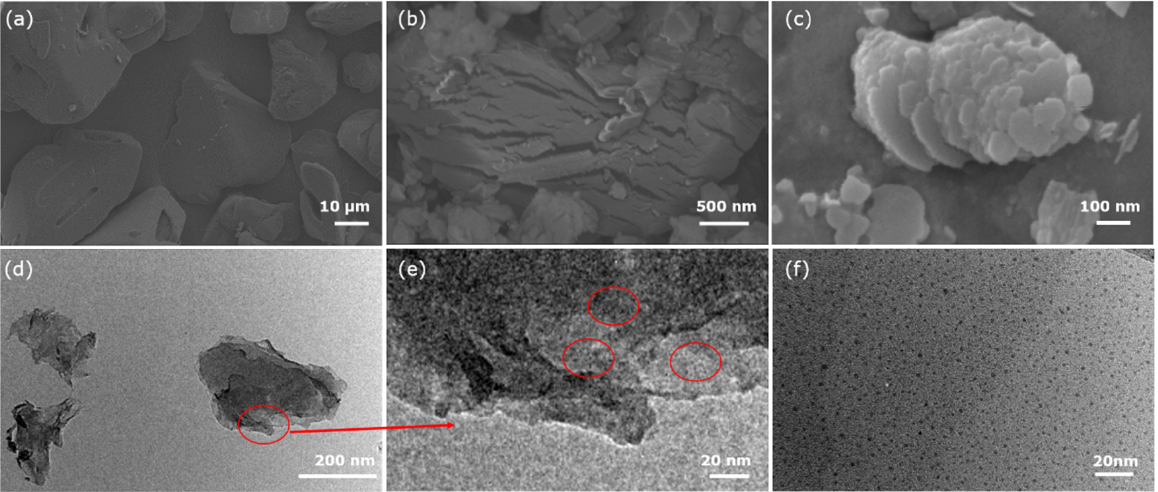
Figure 1. The SEM images of ( a ) melamine, ( b ) melamine precursor, ( c ) bulk O-gCN; the TEM images of ( d ) O-gCN nanosheets, ( e ) the edge of O-gCN nanosheets at higher magnification, ( f ) OCNQDs.